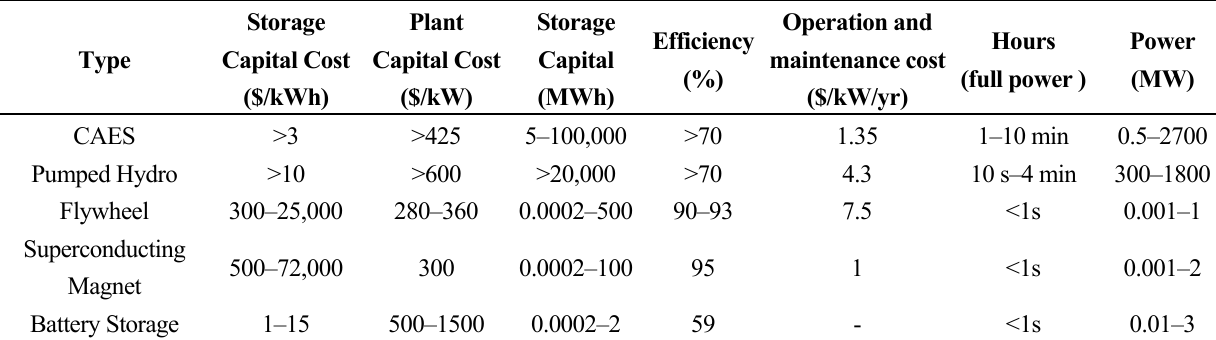
Table 1. Capital cost of installed storage